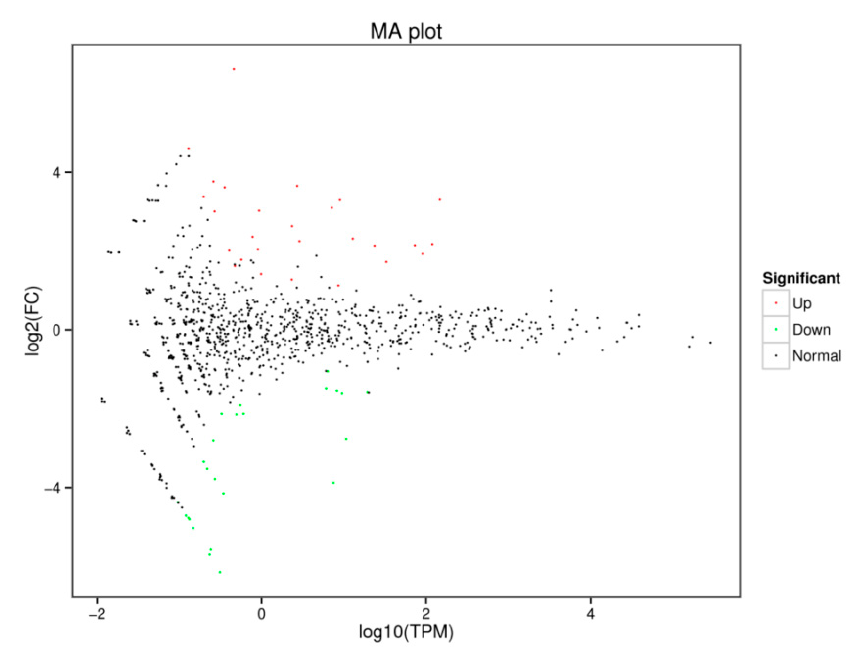
ff erentially expressed miRNA in the CS and CON groups. Animals 2020 , 10 , x